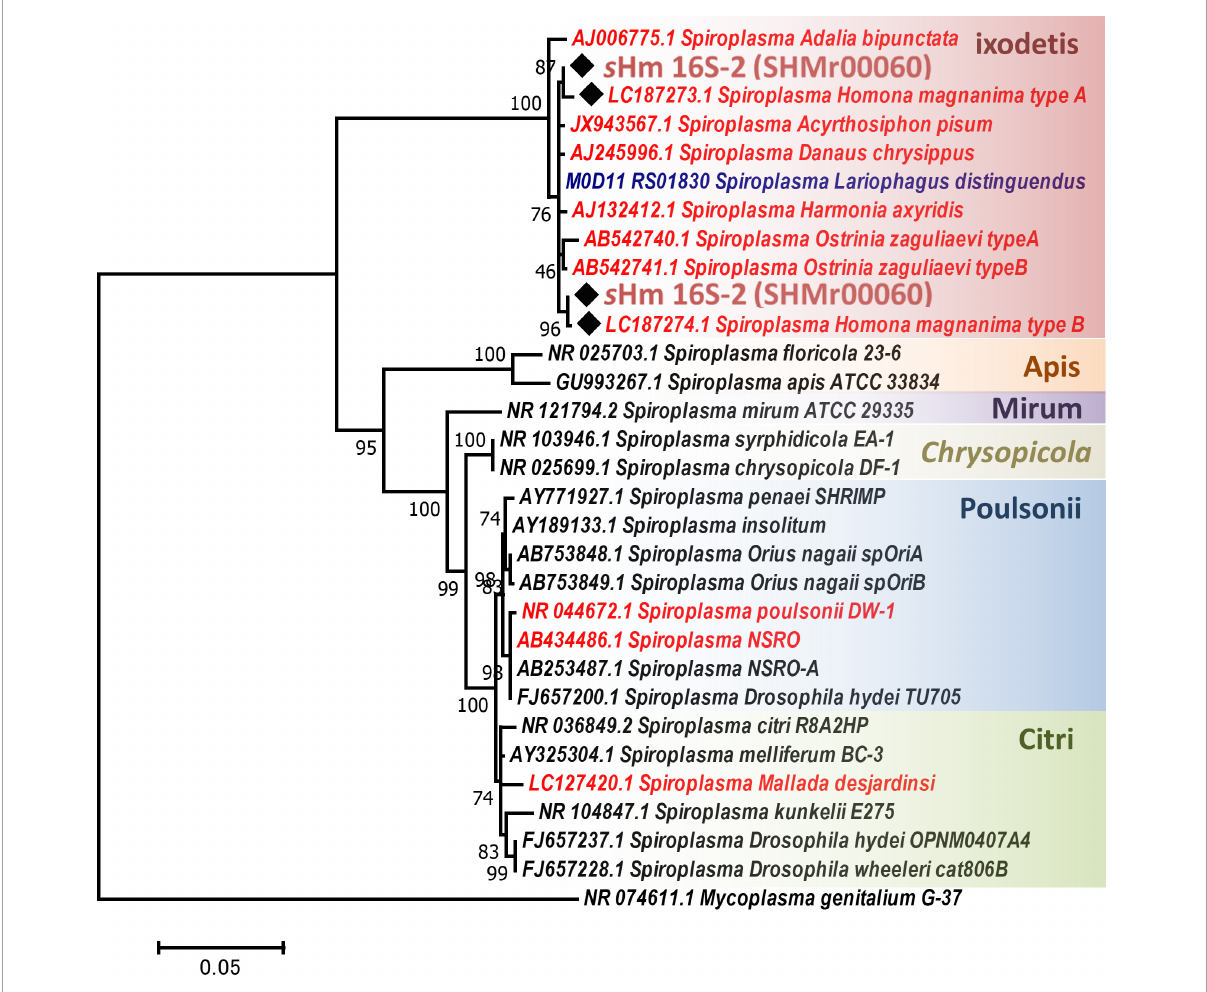
FIGURE2 Phylogenetic tree of Spiroplasma strains based on 16S rRNA gene sequences. Phylogenetic tree based on 16S rRNA gene sequences of strain s Hm and other Spiroplasma strains (retrieved from NCBI database) using maximum likelihood method based on the Tamura–Nei model with 1,000 bootstrap replicates. Accession numbers are shown along with the operational taxonomic units (OTUs). Samples highlighted with red and blue color fonts are MK and CI strains, respectively. Black diamonds indicate 16S rRNA sequences of the s Hm. The classification of Spiroplasma is based on the study by Paredes et al. (2015). Mycoplasma genitalium was used as the